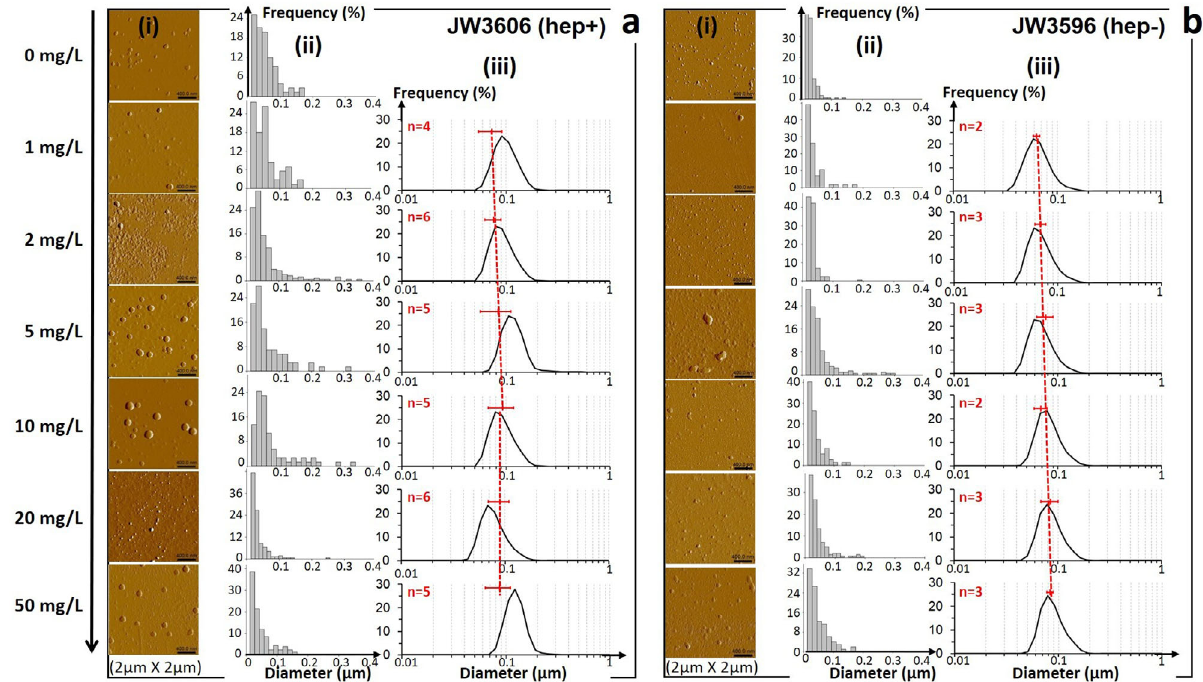
Fig. 4 MV imaging and MV size distributions as a function of TiO 2 NP concentration. i AFM imaging of MVs and ii corresponding estimations of their size distribution, and iii DLS-derived MV size distribution as a function of TiO 2 NP concentration (indicated) for ( a ) JW3606 (hep + ) and ( b ) JW3596 (hep-). In a (iii) and b(iii) , red dotted lines are guides to the eye and horizontal red bars correspond to the position of the maxima (mean values ± standard deviations) derived from DLS measurement of n (indicated) size distributions for suspensions prepared from different cell cultures or colonies, with three replicates for each measurement. The reported illustrative size distributions are averaged over three replicates. DLS measurements of MV size were performed on 0.22 μ m- fi ltered suspensions (1:10 diluted in ultrapure water, see “ Methods ” ) and results were con fi rmed by measurements on 0.45 μ m- fi ltrated suspensions. Qualitative MV size estimations from AFM imaging were based on the analysis of 0.45 μ m- fi ltered suspensions. Detection of MVs by DLS in the absence of TiO 2 NP was not possible due to an insuf fi cient amount of particles in the